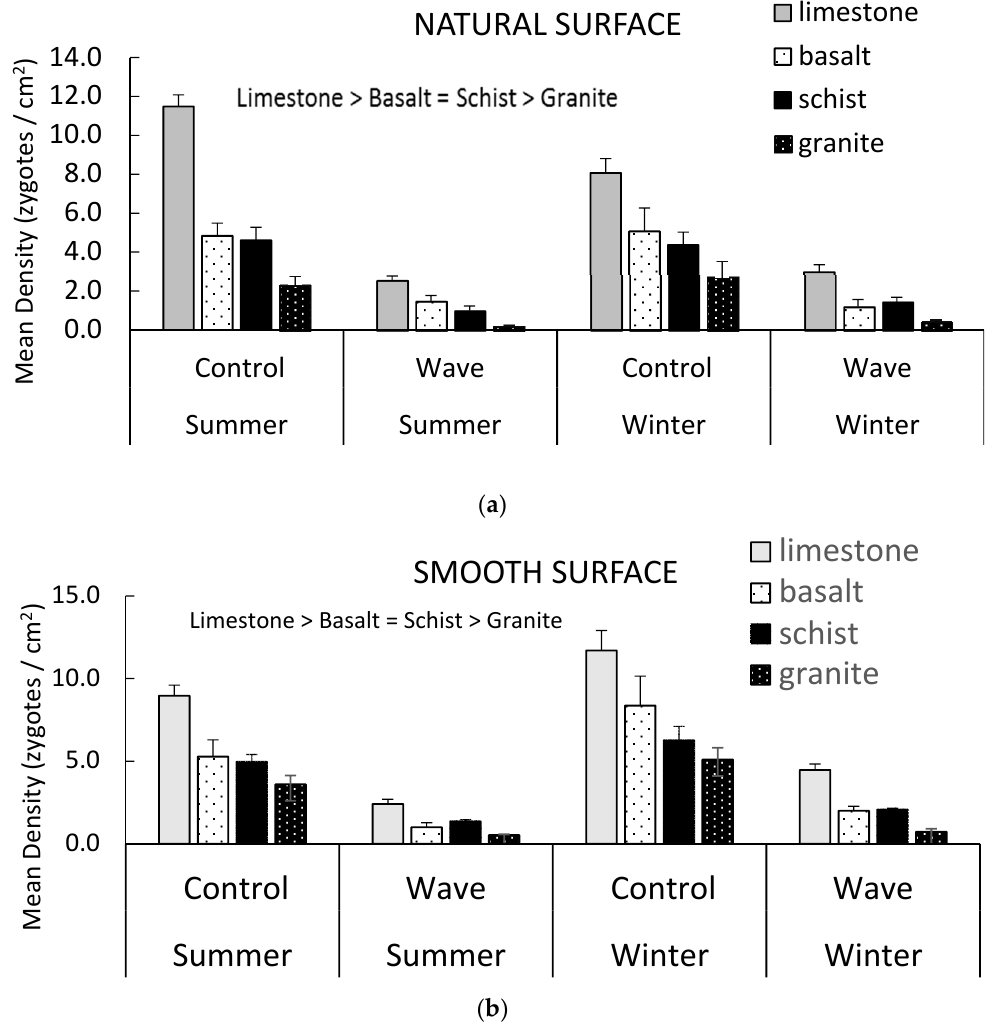
Figure 1. Mean density (zygotes per cm 2 + 1SE, N = 5) of Fucus spiralis zygotes on 4 rock types after 1.5 h of settlement (control) and 1.5 h of settlement followed by one wave in summer and winter experiments. A three-way ANOVA compared zygote density as a function of season, rock type, and wave treatment (wave or no wave) for each surface type: ( a ) natural and ( b ) smooth. The zygote density was higher in winter than summer on smooth plates ( p < 0.001), but there was no significant difference ( p > 0.05) between seasons on natural plates. The density was always significantly lower ( p < 0.0001) regardless of rock type on plates subjected to a wave compared to control plates. The mean density among rock types was compared using Tukey’s HSD post hoc test. For both natural and smooth plates, the density was significantly higher ( p < 0.0001) on limestone than on basalt and schist, which were not significantly different from each other ( p > 0.05); granite had a significantly ( p < 0.0001) lower density than all other rock types.